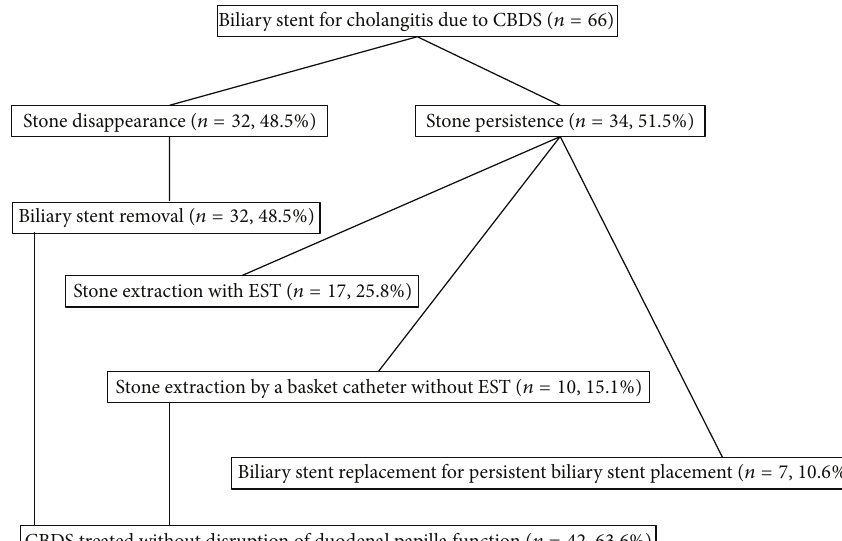
Figure 1: Flow diagram of patients analyzed in this